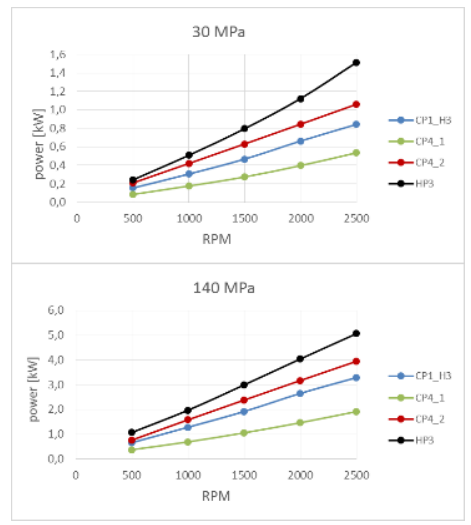
Fig. 1. Comparison of power to pump drive as a function of pump shaft speed for pumping pressures of 30 and 140 MPa